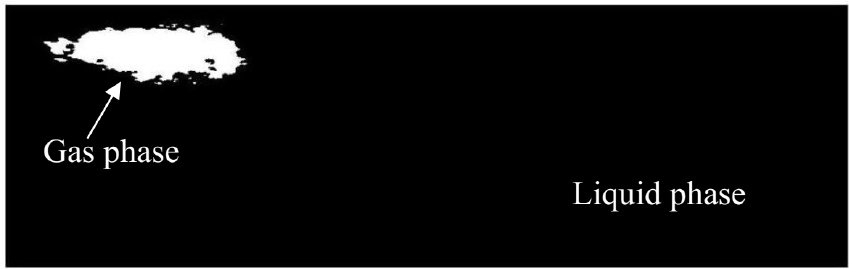
Figure 11. Image after image processing when the pressure is 0.2 MPa and tilted upward by 20°.